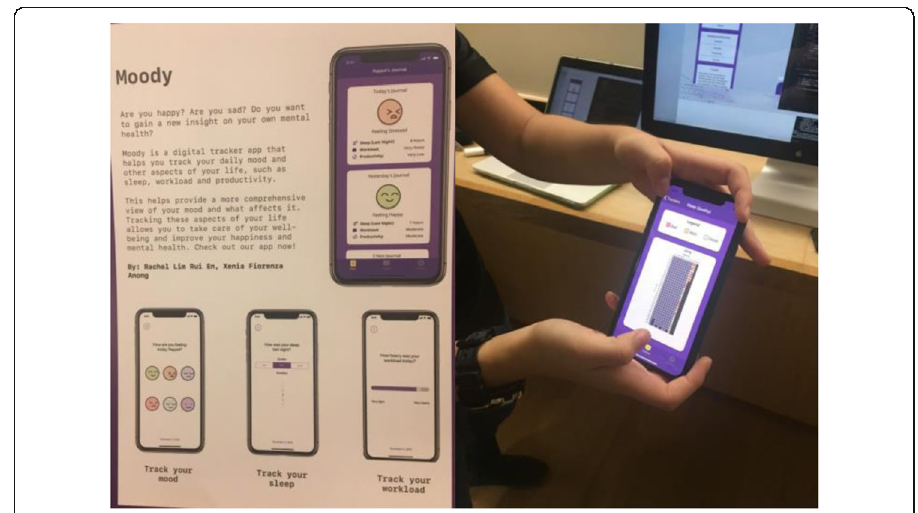
Fig. 6 A student-generated app “ Moody ” to trace daily